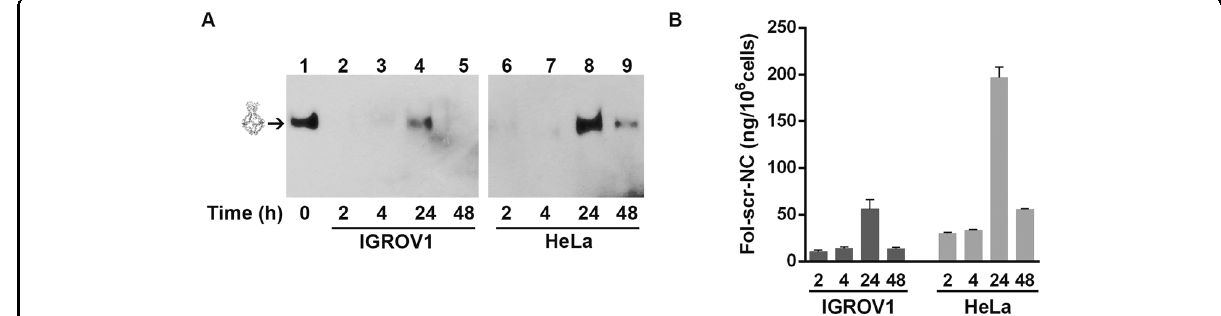
Fig. 2 Time-dependent uptake of Fol-scr-NCs in HeLa and IGROV1 cells. A DNA blot of biotinylated-Fol-scr-NCs puri fi ed from IGROV1 (lanes 2 – 5) and HeLa (lanes 6 – 9) cell lysates at 2, 4, 24, and 48 h incubation time and detected with streptavidin-HRP. Lane 1 shows 30 ng of NCs before incubation with cells (time 0). B Densitometric analysis of the amount of Fol-scr-NCs internalized in cells at 37 °C at different times, as indicated, analyzed with the ImageJ software. Histograms show average values± S.E.M. of three independent